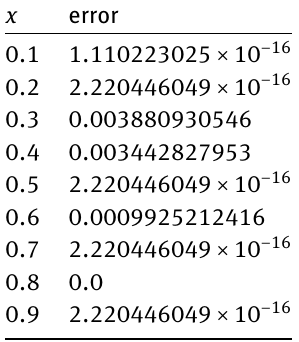
Table 3: The error for the proposed method with n = 8 and λ = 3.51 for Example